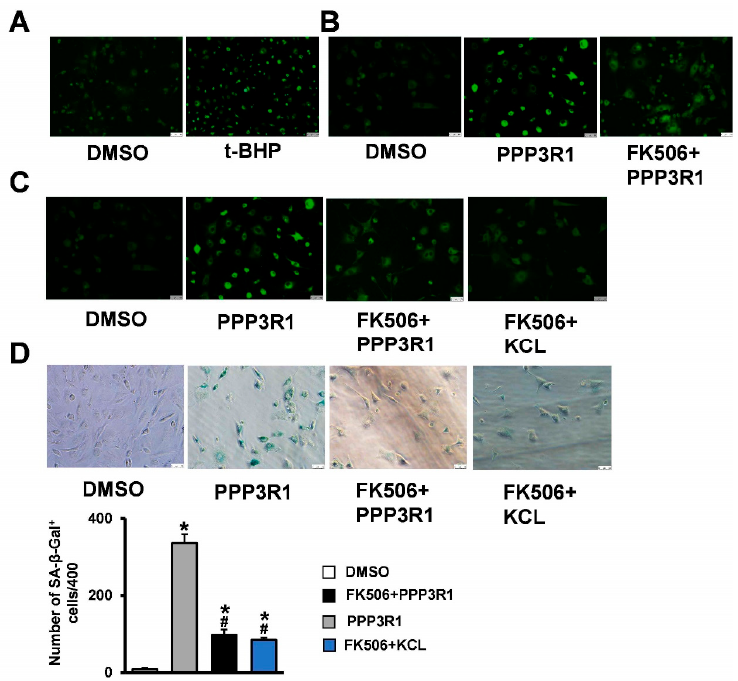
Figure 4. Plasma membrane depolarization induces C3H10T1/2 cell senescence. ( A ) Detection of plasma membrane potential changes in senescent cells by DiBAC4 fluorescent dye staining. After the cells were treated with PPP3R1 recombinant protein, FK506 and KCL, the changes of plasma membrane potential were detected by ( B , C ) DiBAC4 fluorescent dye staining, and cell senescence was detected by ( D ) β -galactosidase staining. * # p < 0.05. (Scale bars: ( A ) 100 μ m, ( B ) 100 μ m, ( C ) 100 μ m, ( D ) 50 μ m).